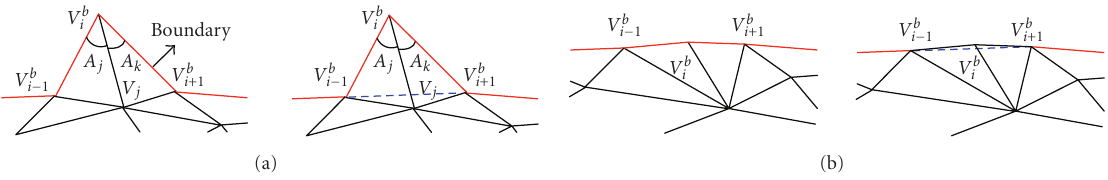
) < απ . (a) Form sharp corner; (b) Generate triangle with interior angle i